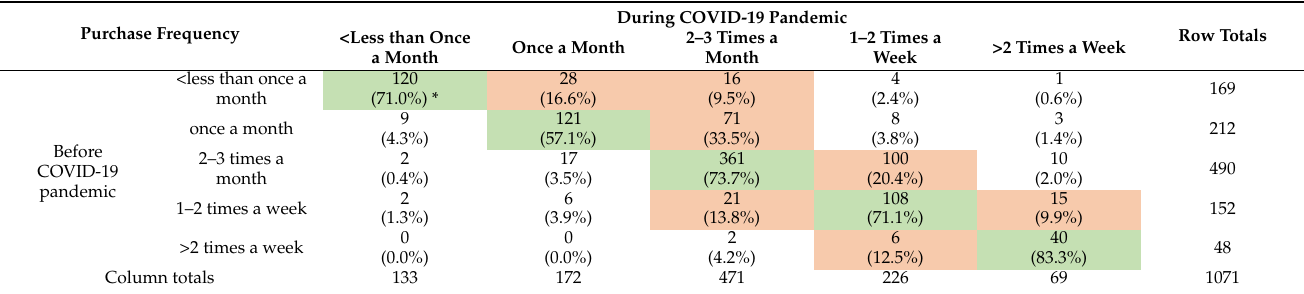
Table 4. Changes in online purchases of rural e-customers before and during the COVID-19 pandemic ( p = 0.0000) (own elaboration).